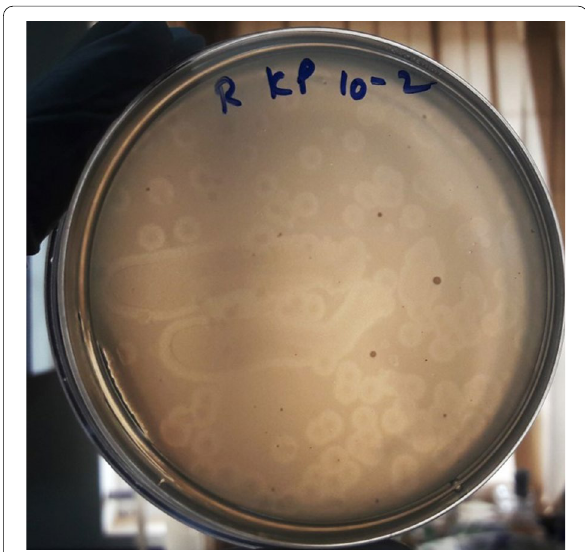
Fig. 1 Plaque morphology of the Klebsiella pneumoniae specific phages isolated from Ganges river (KpG) The Ganges water from Rishikesh was enriched with the host and plated by agar overlay method. KpG shows depolymerase activity, which is evident from the halo around the plaques